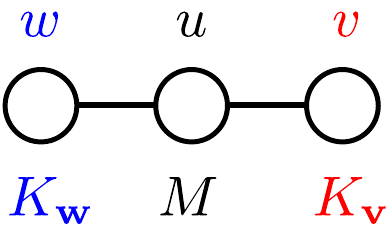
Figure 15 . Dynkin diagram of SO(6) and rapidities. The rapidities associated with the middle node describe the actual propagation of magnons on a spin chain while the rapidities associated with the wings correspond to the spin-wave excitations which describe the index structure of magnon wave